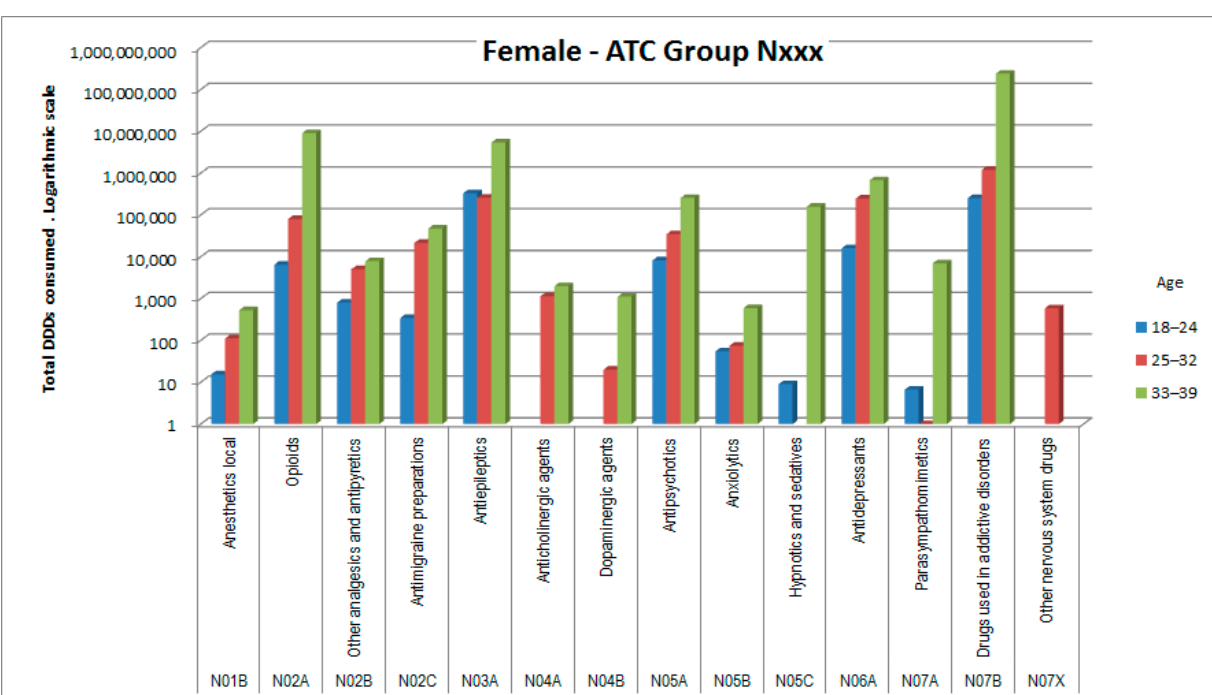
Healthcare 2021 , 9 , x Figure 9. DDD consumption for females, ATC group Nxxx. Figure 9. DDD consumption for females, ATC group Nxxx.